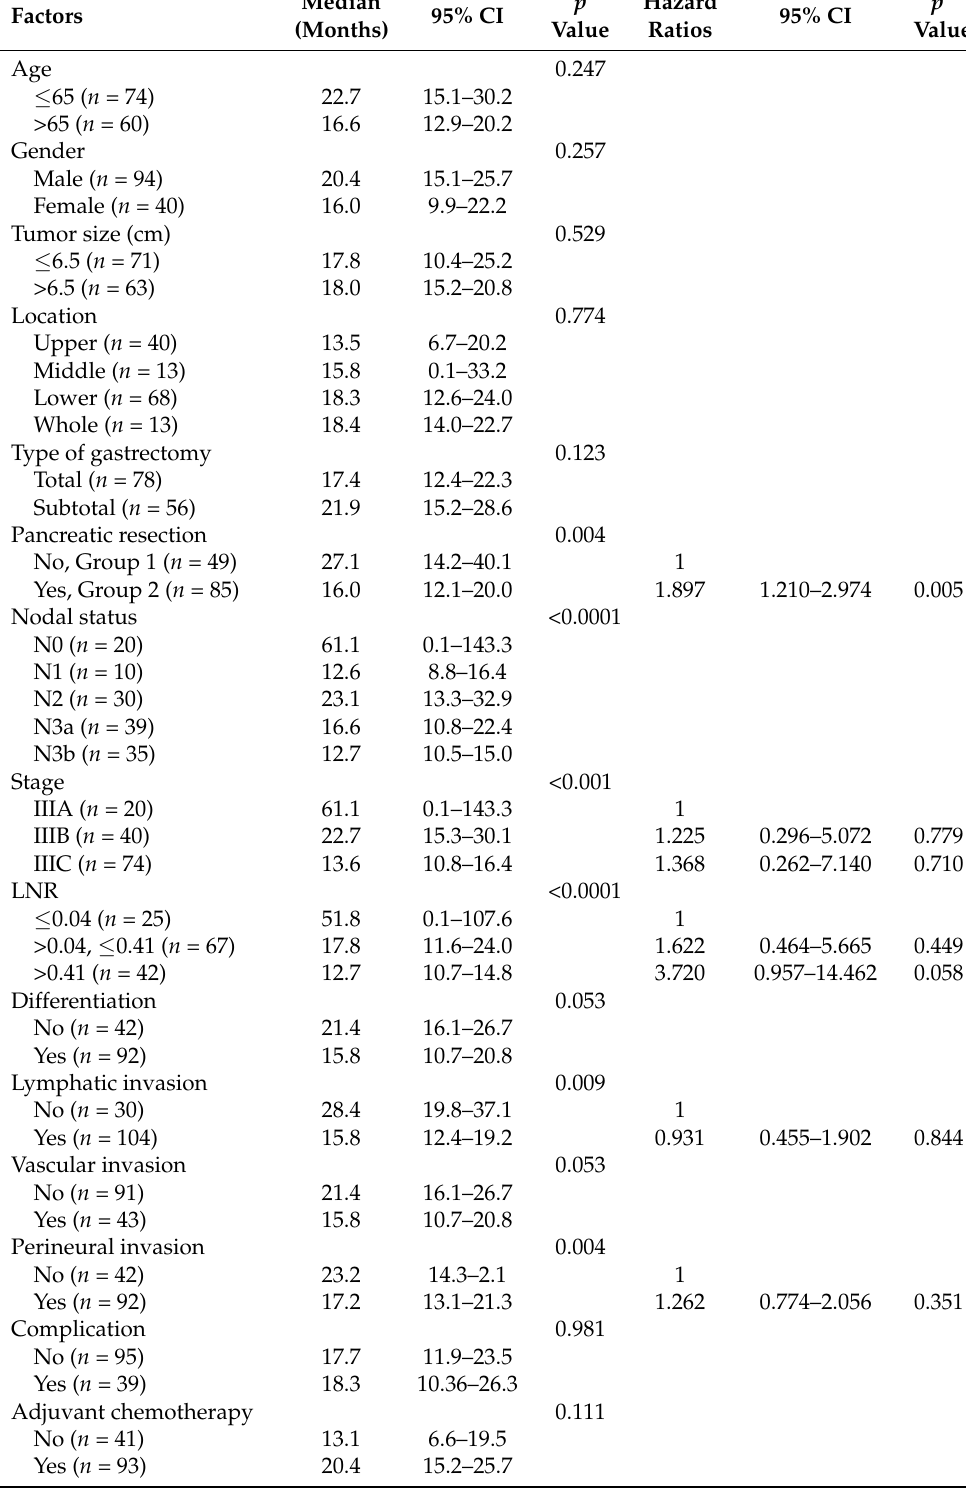
Table 3. Univariate and multivariate analysis of prognostic factors for overall survival in group 1 and 2